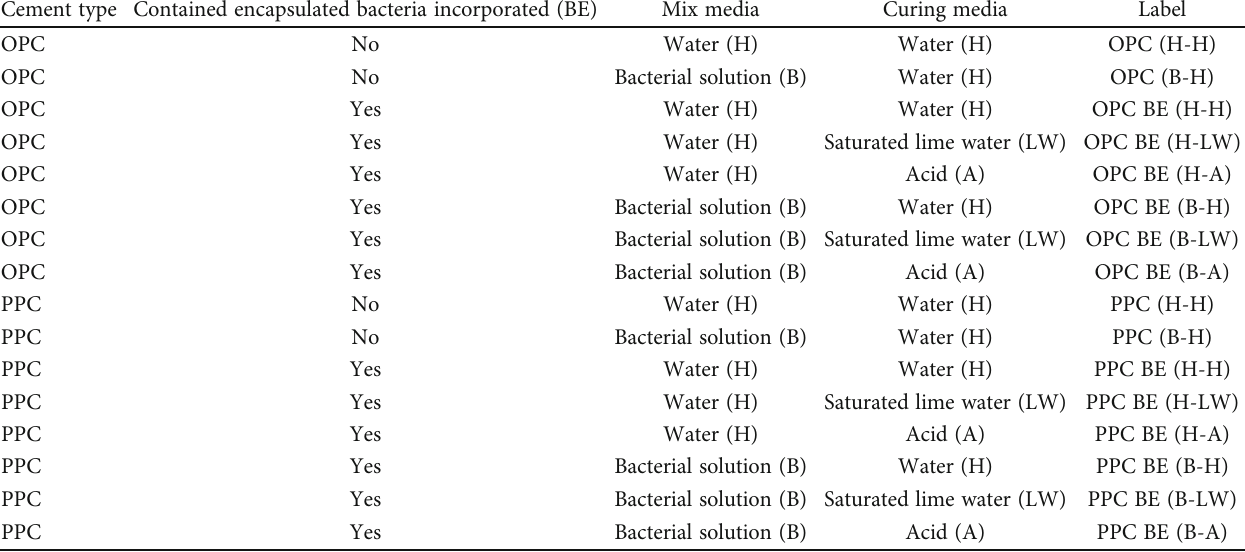
Table 1: Labelling of mortar prisms. Cement type Contained encapsulated bacteria incorporated